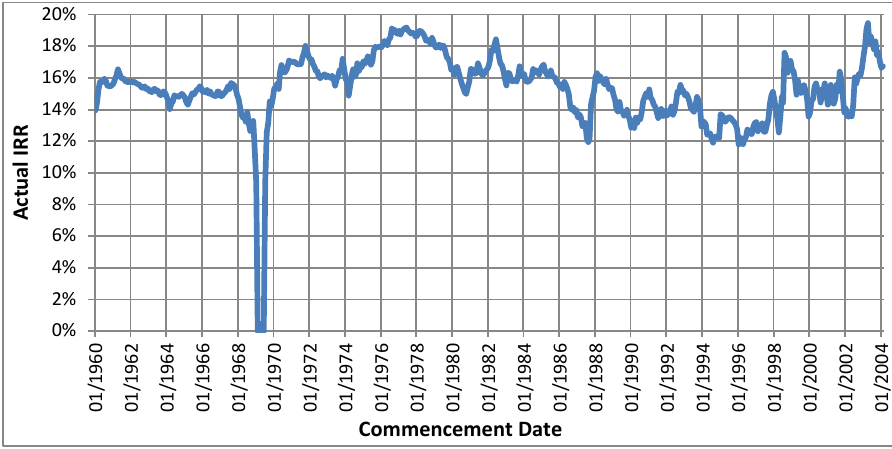
FIGURE 7: IRRs of Set E of simulated living annuities investing in the Alsi Source: Authors’